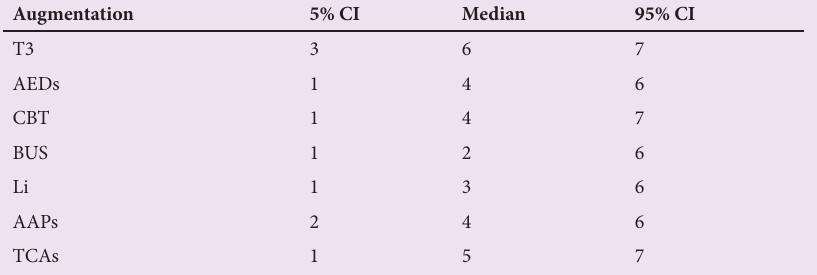
Table 4. Ranked number of augmentations